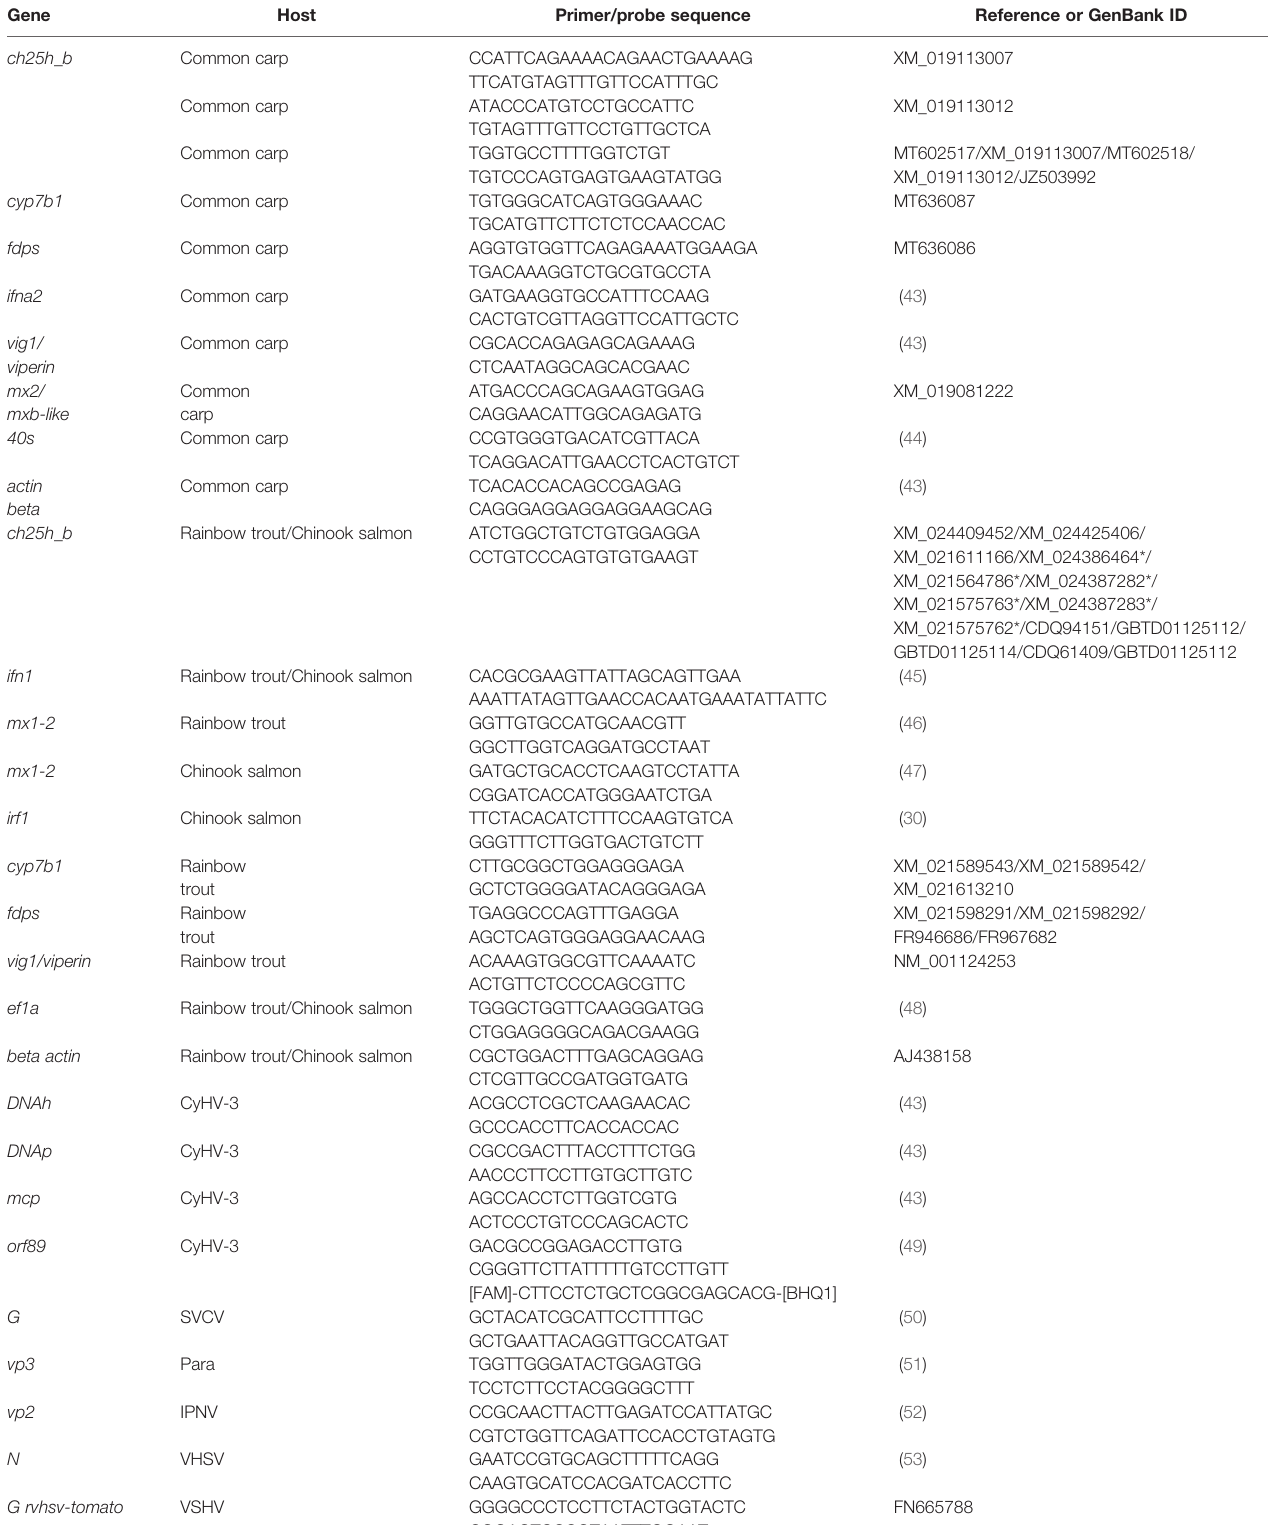
TABLE 1 | Sequences of the PCR primers used in this